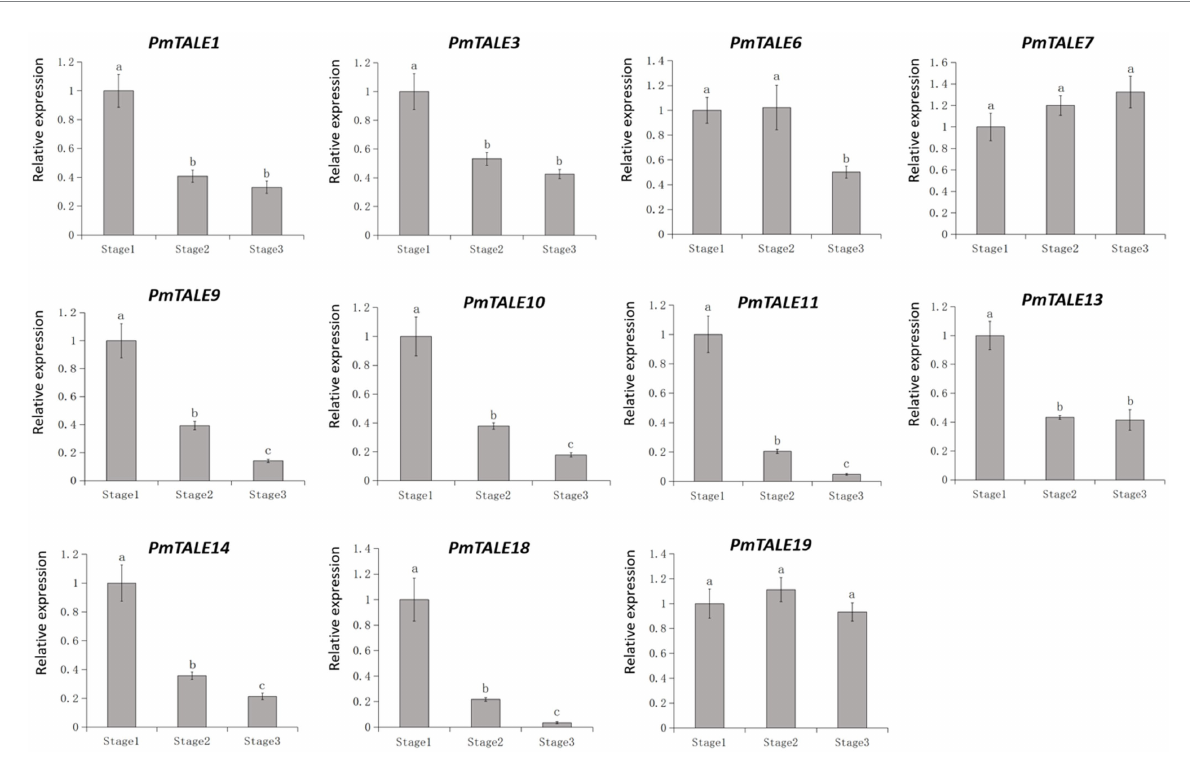
FIGURE 12 The expression profile of Prunus mume TALE gene family at different developmental stages of the stem. The abscissa represents the three stages of Prunus mume stem development, and the ordinate represents the relative expression